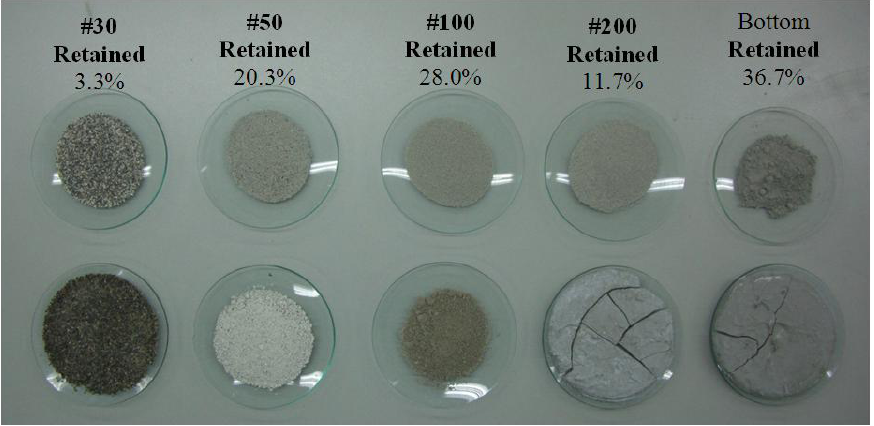
Figure 4. Five discrete particle size fractions and their mixes with